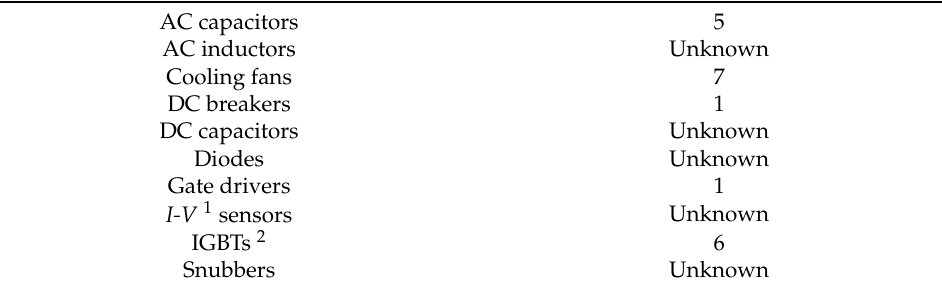
Table 2. Number of components for a single